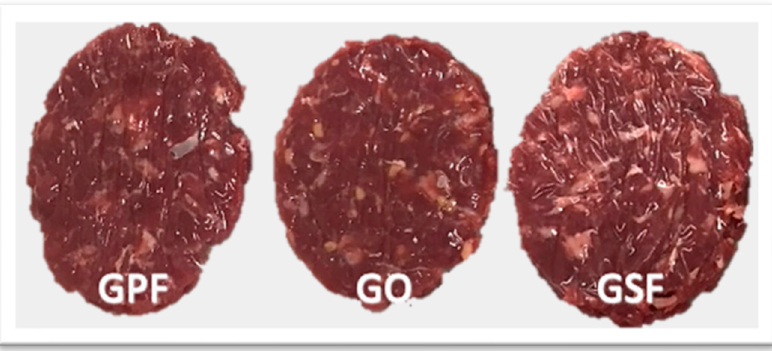
Table 1. Formulation of goat meat burgers expressed in percentage.